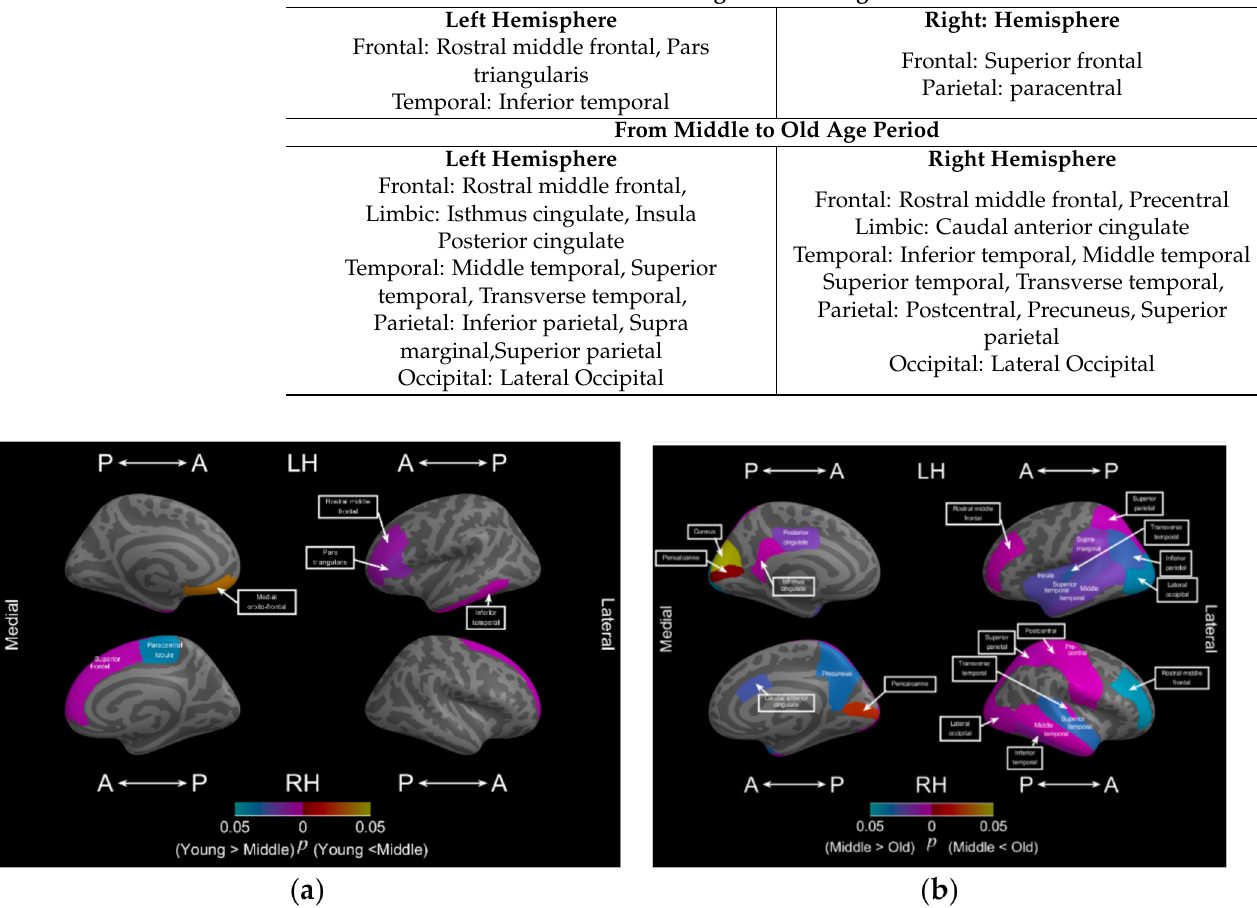
Figure 3. Significantly decreased FD values in cortical subregions between different age period; ( a ) significant decrease in FD values in cortical subregions from young to middle age; ( b ) significant decrease in FD values in cortical subregions from middle to old